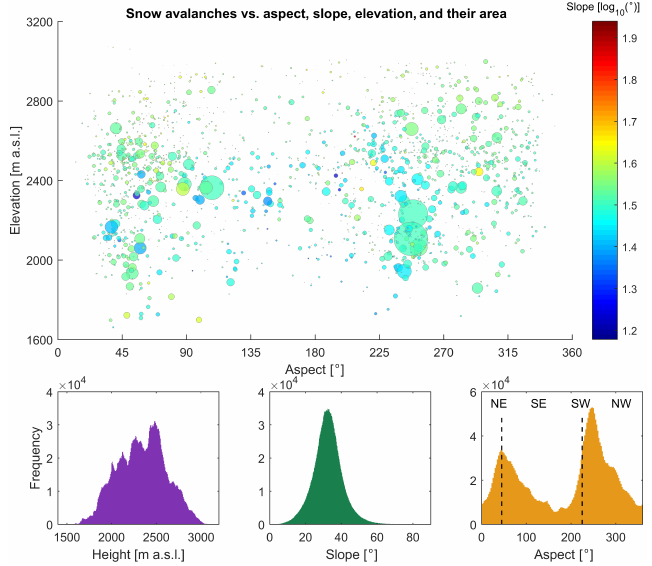
Figure 7. Elevation, slope, and aspect of mapped reference avalanches with marked north-east and south-west directions in the winter of 2012–2013. The values presented for every single avalanche represent the mean value of each pixel contained inside the reference avalanche polygon. Bubble size on the scatter plot is scaled to avalanche